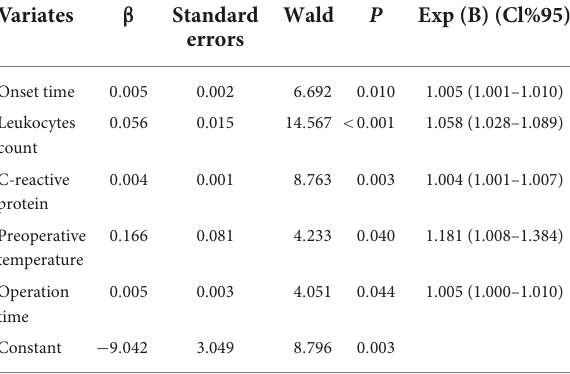
TABLE 3 Multivariate logistic regression for predictive